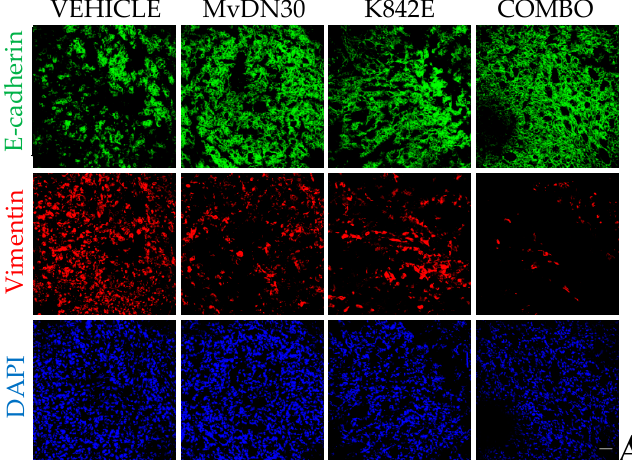
Figure 4. Concomitant MET/HGF targeting induces a reversion of the epithelial-to-mesenchymal transition (EMT) phenotype as well as a decrease of activated α -SMA positive fibroblasts in an orthotopic model of pancreatic cancer. HPAF-II cells were orthotopically injected in SCID mice genetically modified to secrete physiological levels of human HGF (hHGF knock-in); after 2